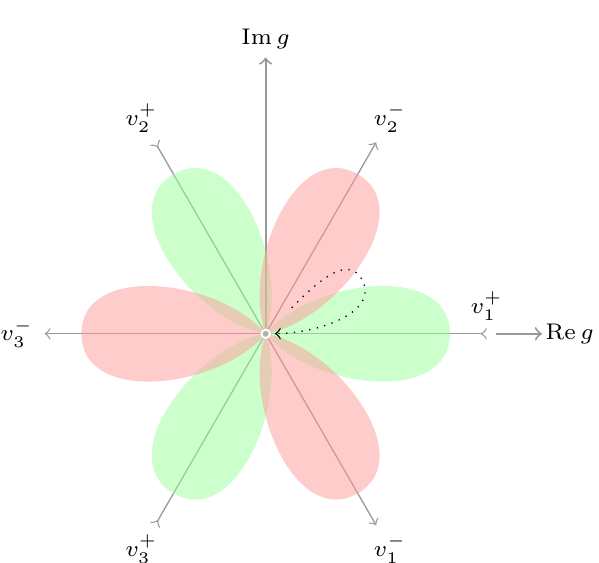
Figure 11: Attracting (green) and repelling (red) petals of a dynamics of multiplicity 4, and a typical trajectory.